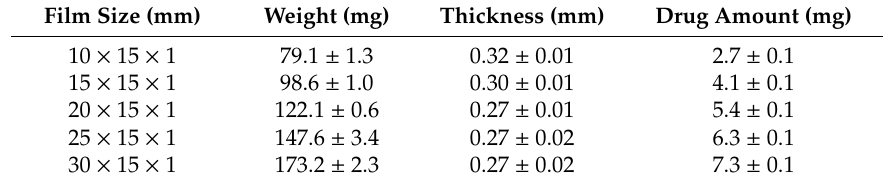
Table 4. Measured weight, thickness, and drug amount of semi-solid extrusion (SSE) 3D printed